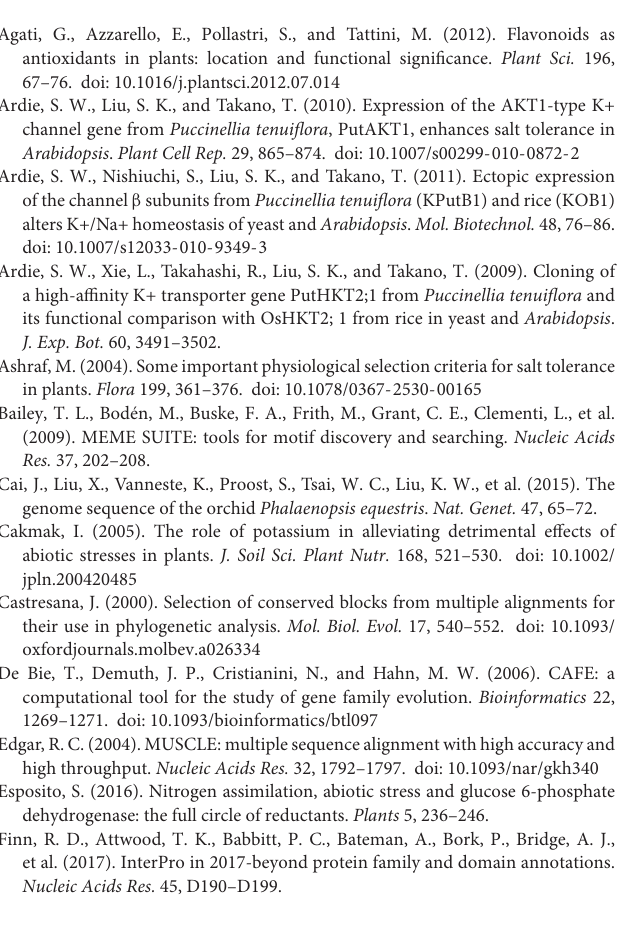
Supplementary Table 1 | Members of the P. tenuiflora gene families that expanded during evolutionary history.